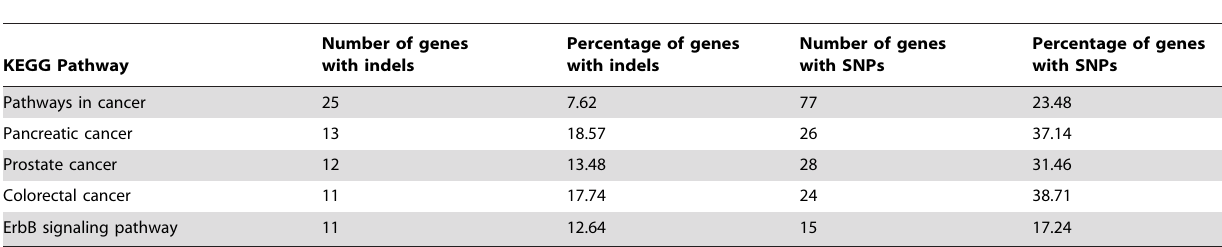
Table 1. Selected human disease pathways containing genes with indels and SNPs in miRNA target sites.